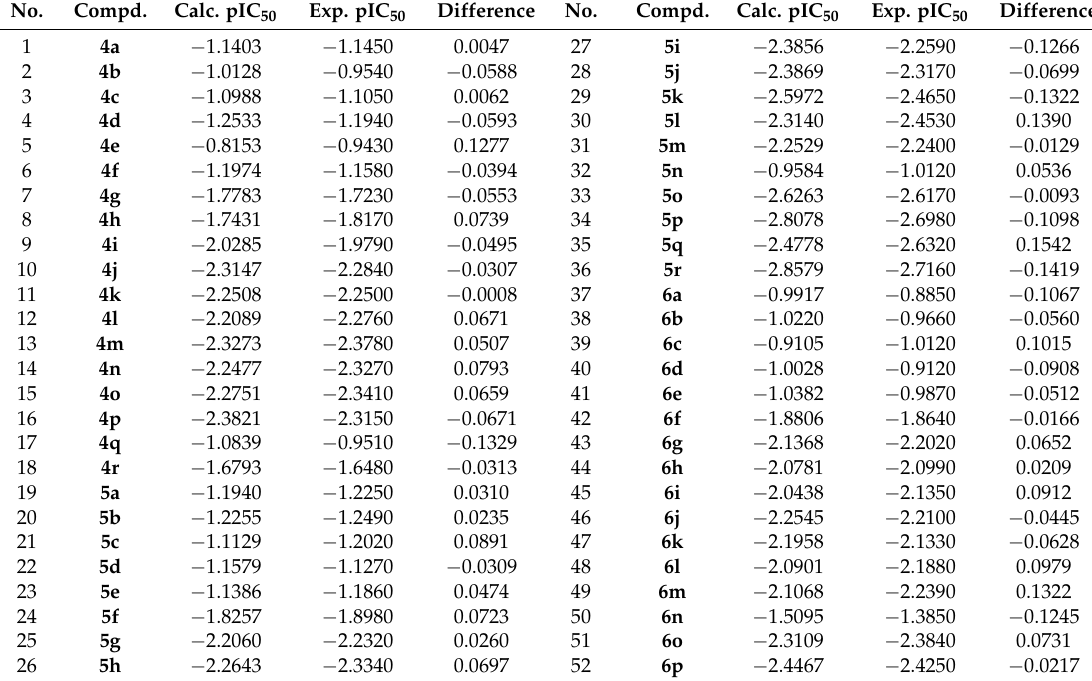
Table 4. The difference between the experimental pIC 50 and predicted pIC 50